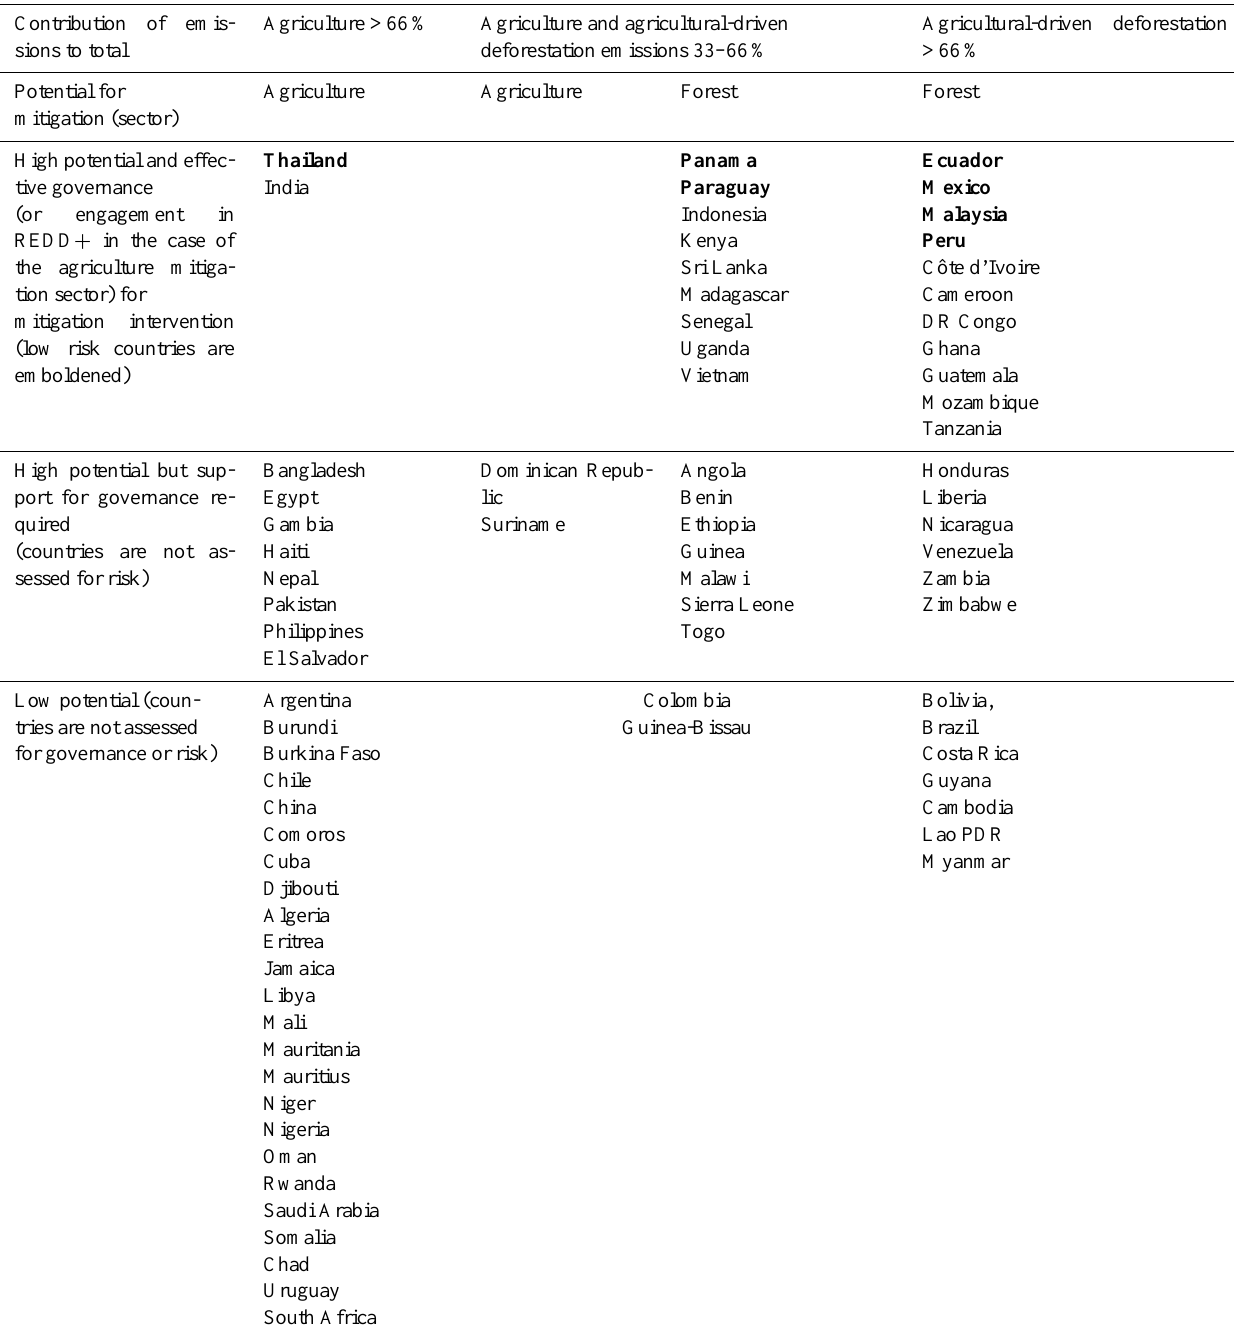
Table 4. Countries are categorized into mitigation intervention classes according to the results of the decision-making tree (Fig. 1) which identifies target countries for mitigation interventions using thresholds for input data (Table 1). Priority countries (with low risks) for inter- ventions are emboldened (countries for which data are unavailable for the full analysis are not